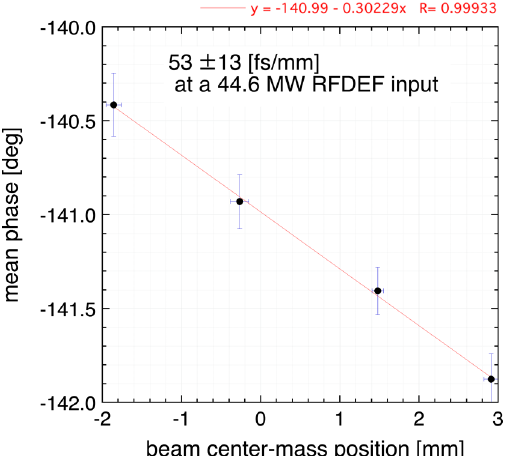
FIG. 30. Calibration of the temporal resolution of the bunch- length measurement system using the RFDEF. The calibration factor of the temporal resolution of the RFDEF is 53 (cid:3) 13 fs = mm . The error bars are STD.